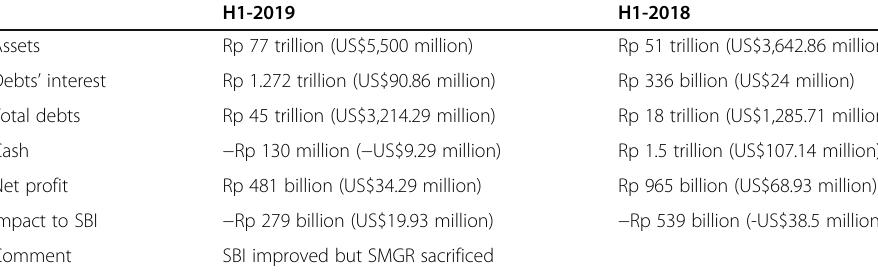
Table 3 Evaluation of H1 financial statement of